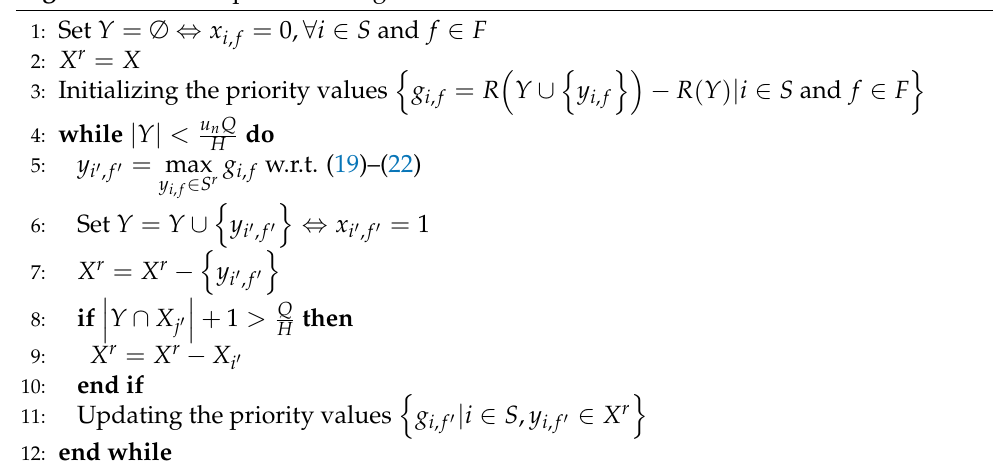
Algorithm 1 Cache placement